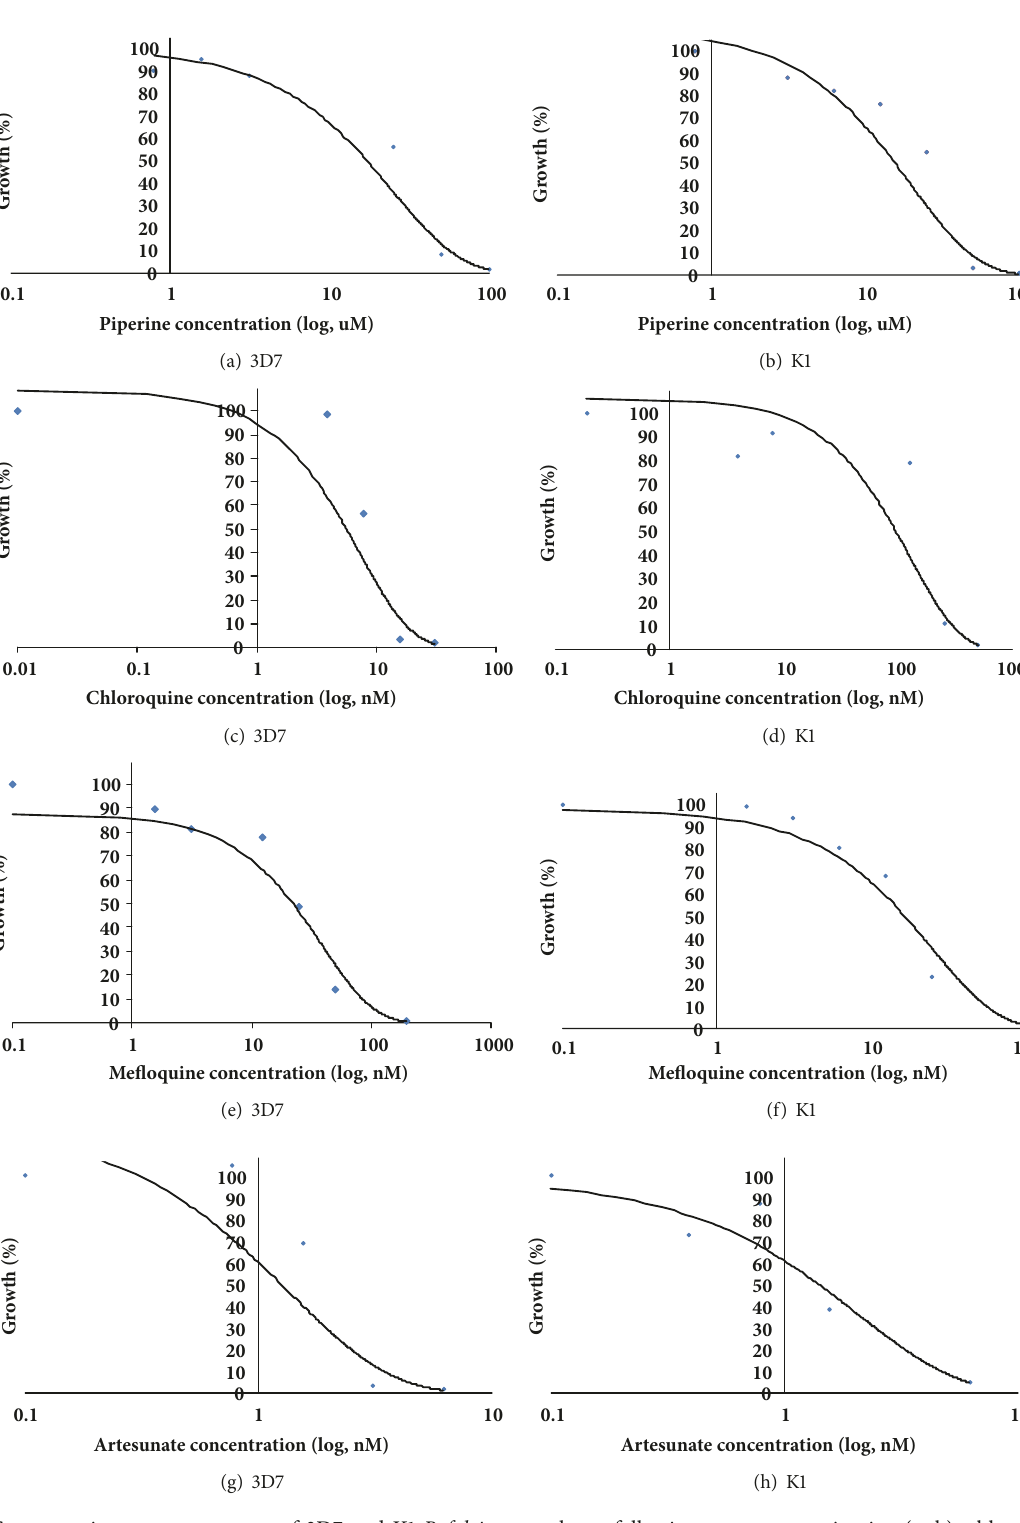
Figure 1: Concentration-response curves of 3D7 and K1 P. falciparum clones following exposure to piperine (a, b), chloroquine (c, d), mefloquine (e, f), and artesunate (g, h). Data are presented as the median value of three independent experiments, triplicate